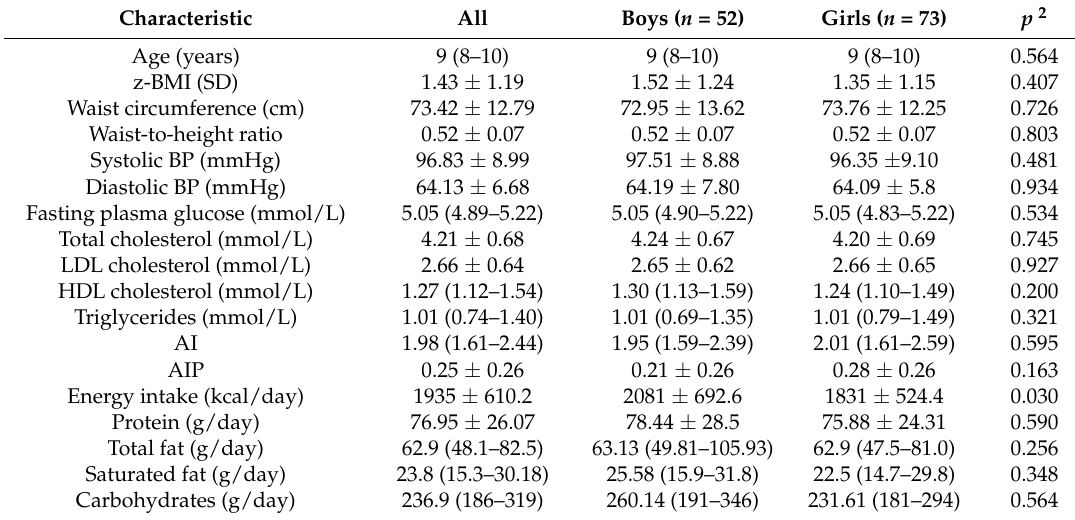
Table 1. Characteristics of the sample by gender 1